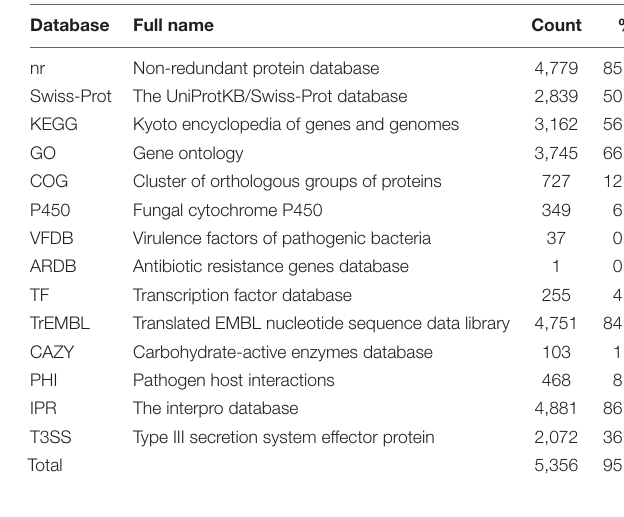
TABLE 3 | Annotation of the predicted genes using a variety of